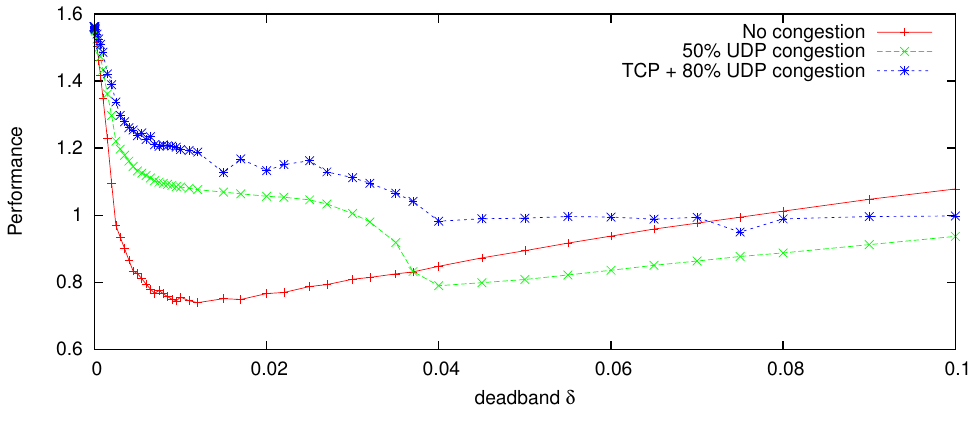
Figure 9. Constant deadband, experimental and approximated for a gantry-crane. Reference t ) . signal is 10 sin (2 π 1 15